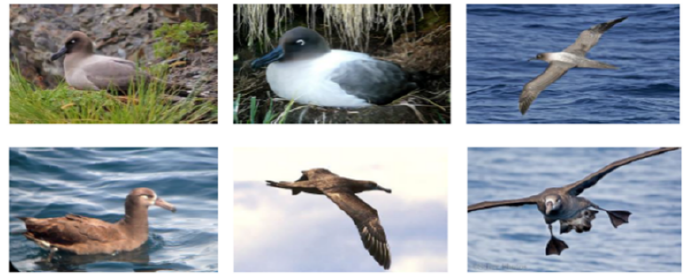
Figure 6. Sample images from the CUB-200-2001 dataset.